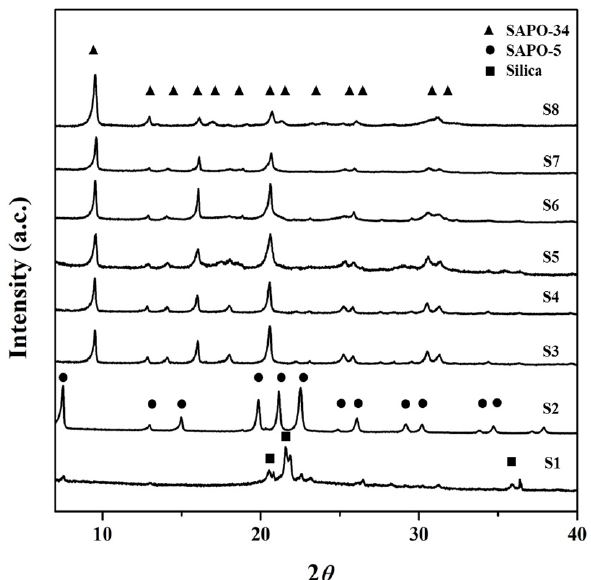
Figure 1. XRD of as-synthesized SAPO-34 particles with variation of template concentration ( x ).